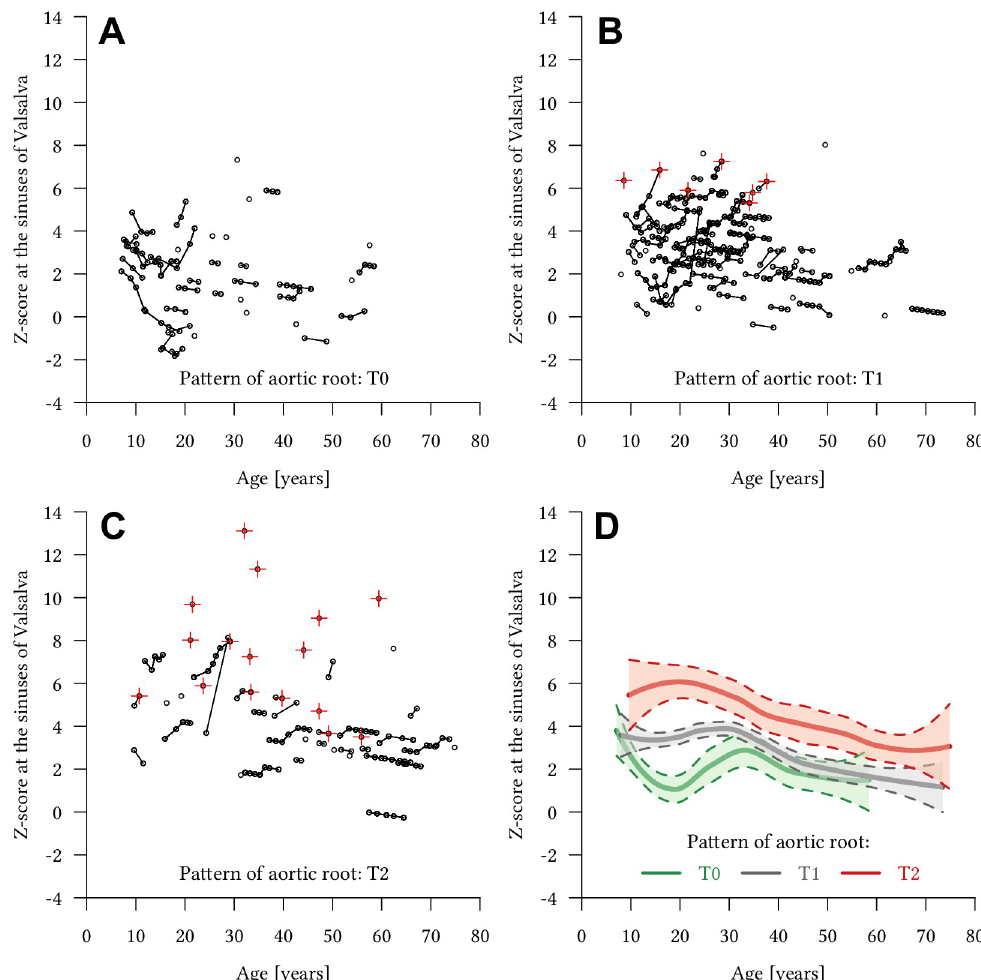
Fig 5. Spaghetti graphs of Z-scores for different shapes of the aortic root in Marfan patients. Spaghetti graphs for all 160 Marfan patients with (A) normal aortic root shape (T0), (B) localized annulo-aortic dilatation (T1), and (C) generalized aortic root dilatation (T2). Red crosses indicate that aortic MR angiography-derived Z-scores were directly followed by aortic root replacement. Note that all patients undergoing surgery had an altered shape of the aortic root (T1 or T2) and the high proportion of patients with generalized aortic root dilatation undergoing surgery (T2). (D) Local regression analysis of all three types of aortic root shape (T0 = green, T1 = grey, T2 = red) with 95% confidence intervals in all 160 Marfan